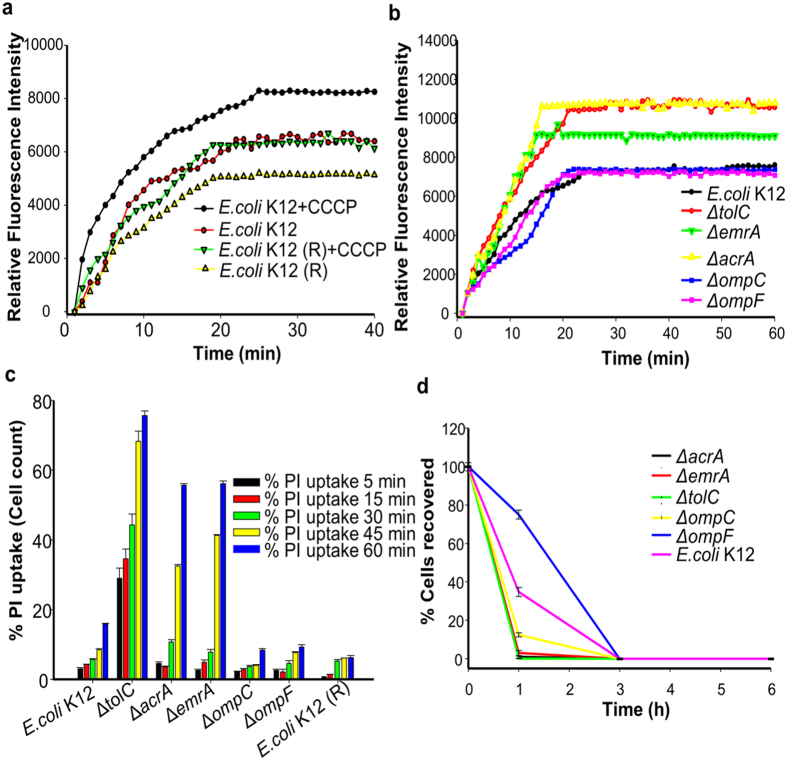
PPEF is subjected to efflux pumps.Time dependent analysis of accumulation of PPEF and bacterial cell death by fluorometric analysis, flow-cytometry and Time kill assay. (a) Accumulation of PPEF by E. coli K12 and de novo generated PPEF resistant E. coli K12 in presence and absence of CCCP over a period of 30 min incubation period. (b) Accumulation of PPEF in E. coli K12 & ΔtolC, ΔompC, ΔacrA, ΔemrA and Δomp F derived E. coli K12 mutants. (c) Percentage cell count of PI uptake quantified in E. coli K12 and other derived mutants treated with PPEF for the time points 5, 15, 30, 45 and 60 min by flow cytometer. Results are presented in mean (±SD) of three independent experiments (n = 3). (d) Percentage (%) of CFU recovered for E. coli K12 and derived mutants following treatment with PPEF. These data represent the result of mean (±SD) of three independent experiments (n = 3).